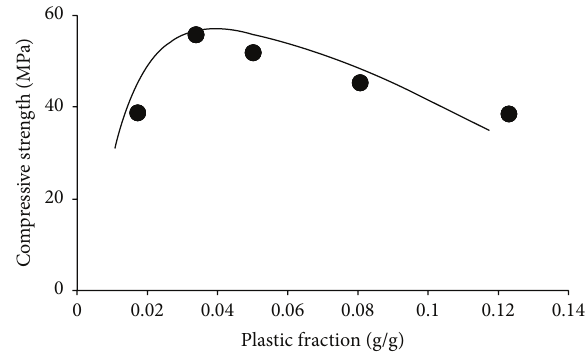
Figure 7: Effect of the plastic mass fraction on the composite compressive strength. The other parameters used were as follows: 3 g PVAc, 4g GS, 5 g GL, 1.5 g paper, 1g cloth, 13 mL water, and a hot-press temperature of 250 ∘ C.